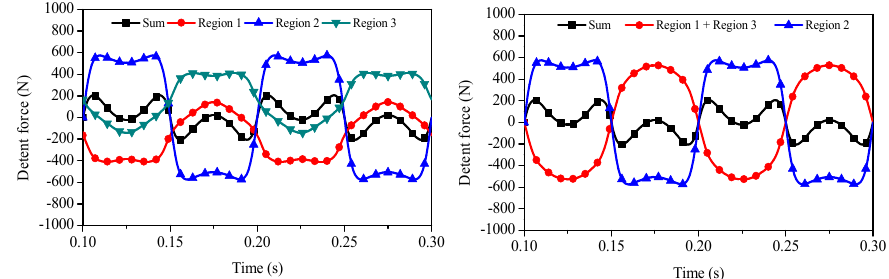
Figure 15. Detent force on each region when shifting length is 8.625 mm.